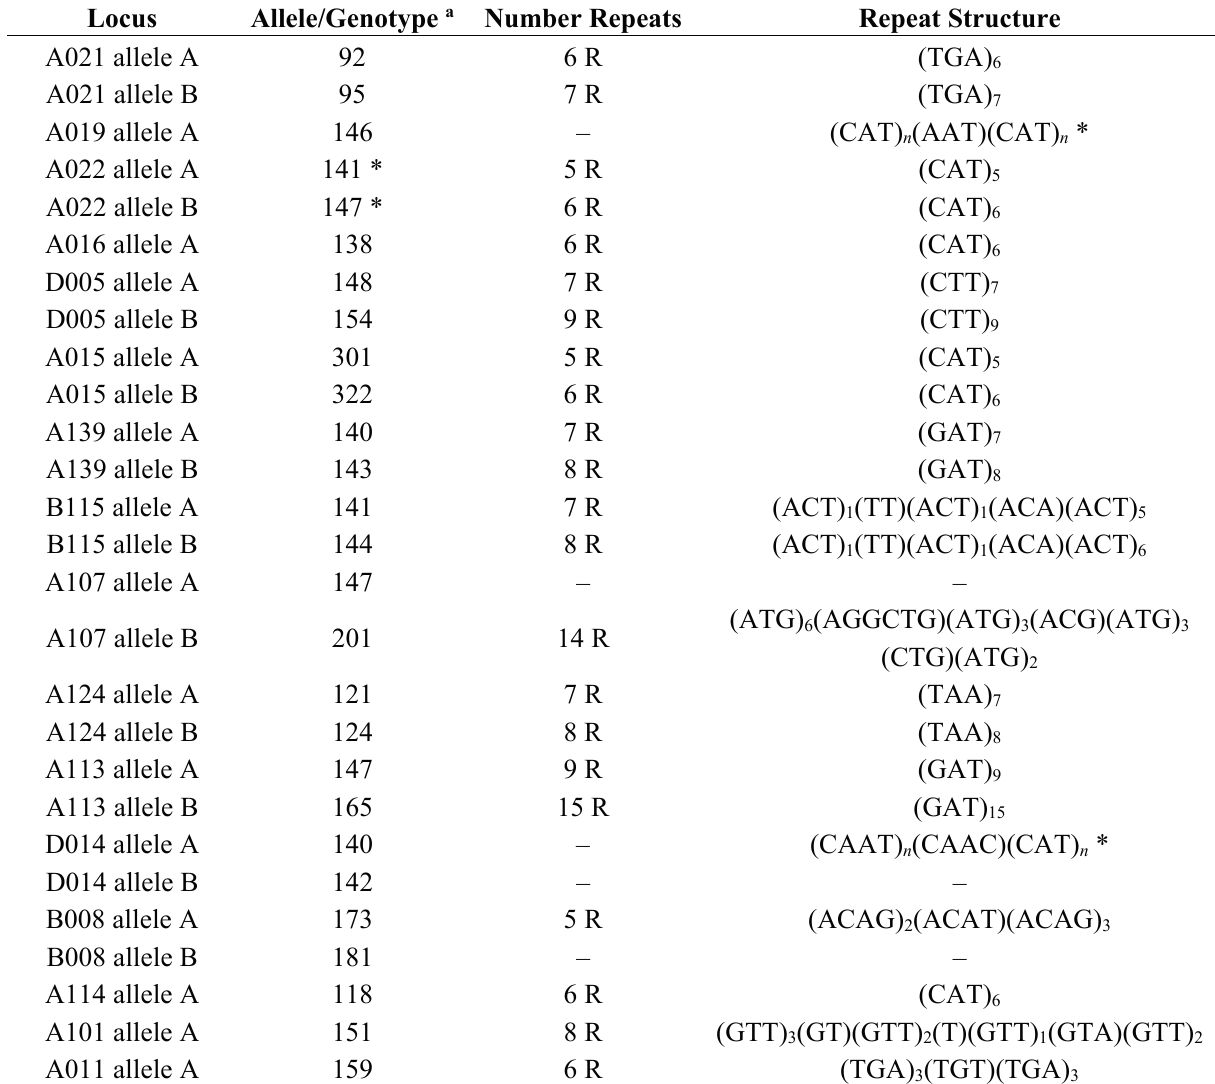
Table 3. DNA sequencing of tandem repeat structure of 21 microsatellites from E.